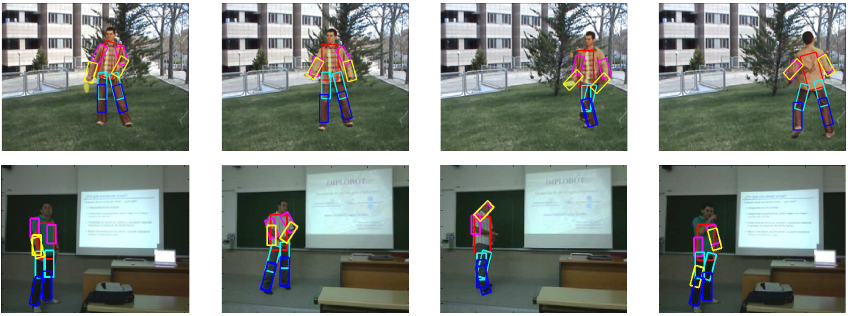
Figure 8. Pose recovery results in cVSG